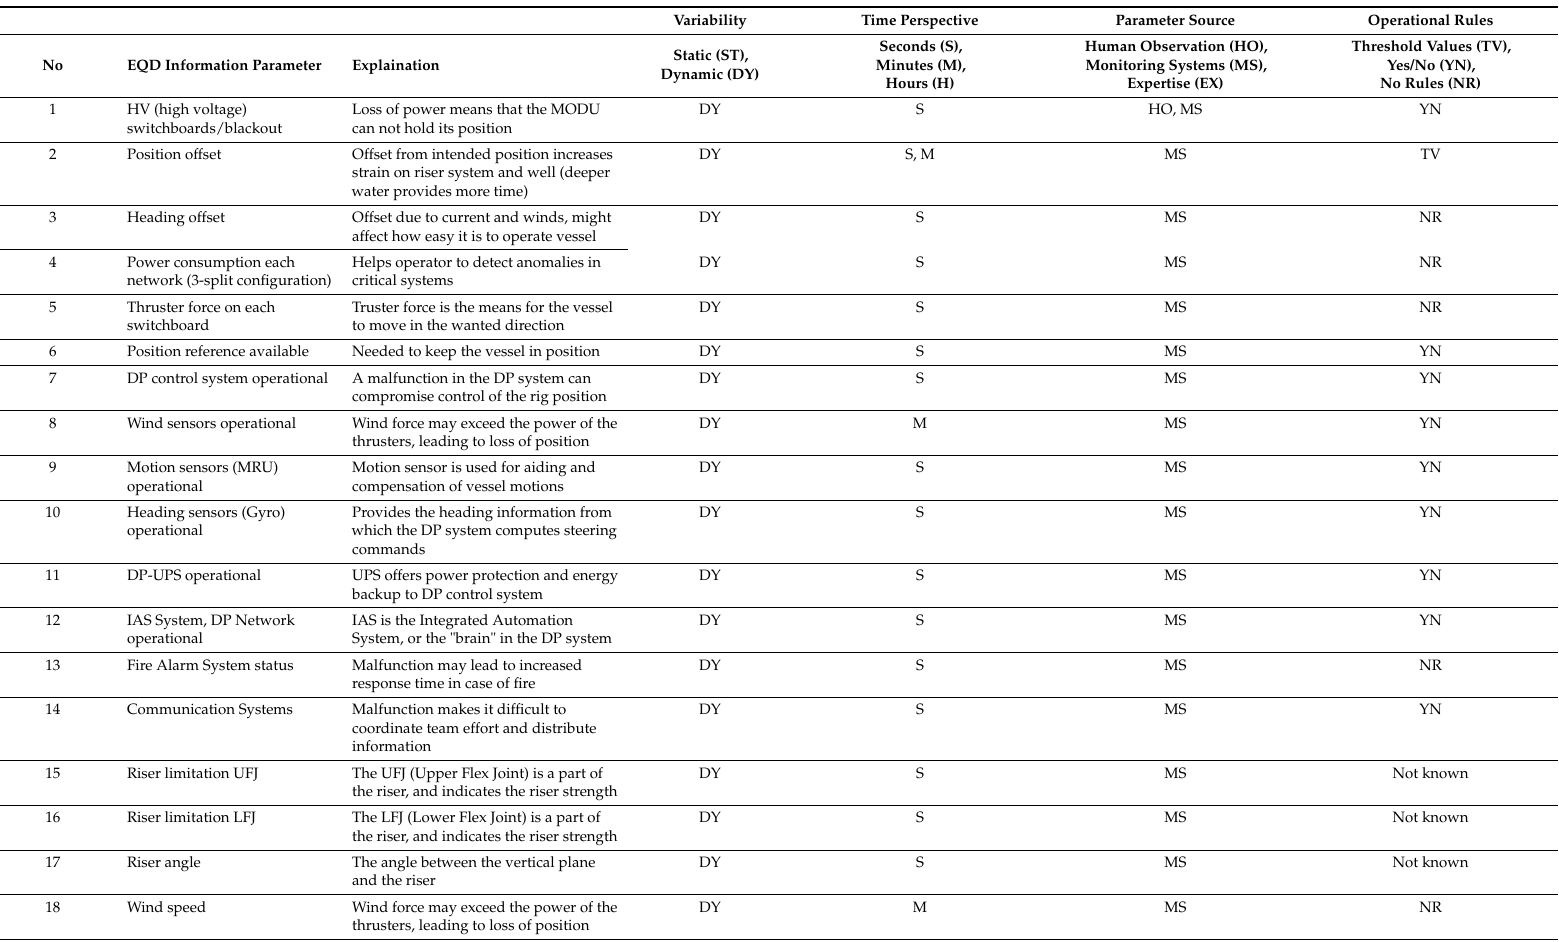
Table A1. Complete Table with Identified Information Parameters and Their Attributes. Variability Parameter